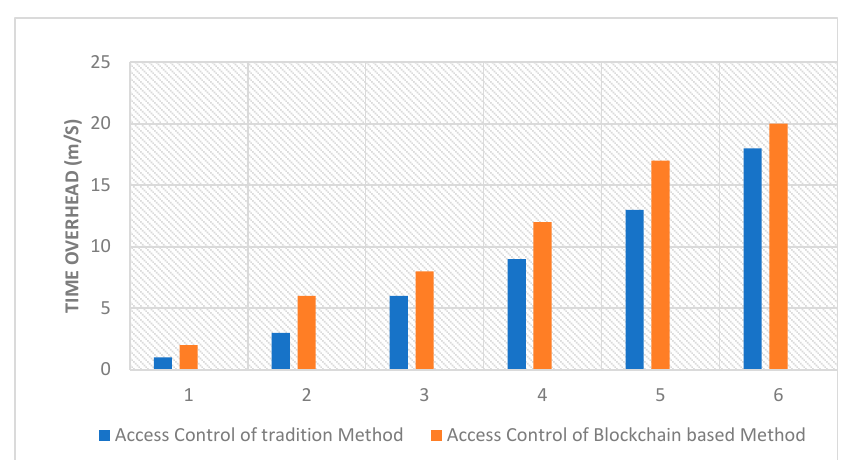
Figure 7. Comparison of Access Control.